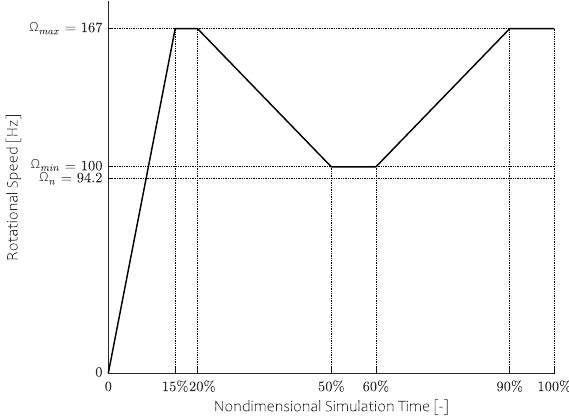
Figure 3. Standardized speed profile, nominal speed = 167 Hz. Total simulation time is 90